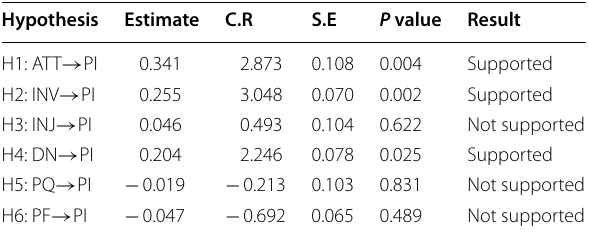
Table 6 Hypothesis tests (path